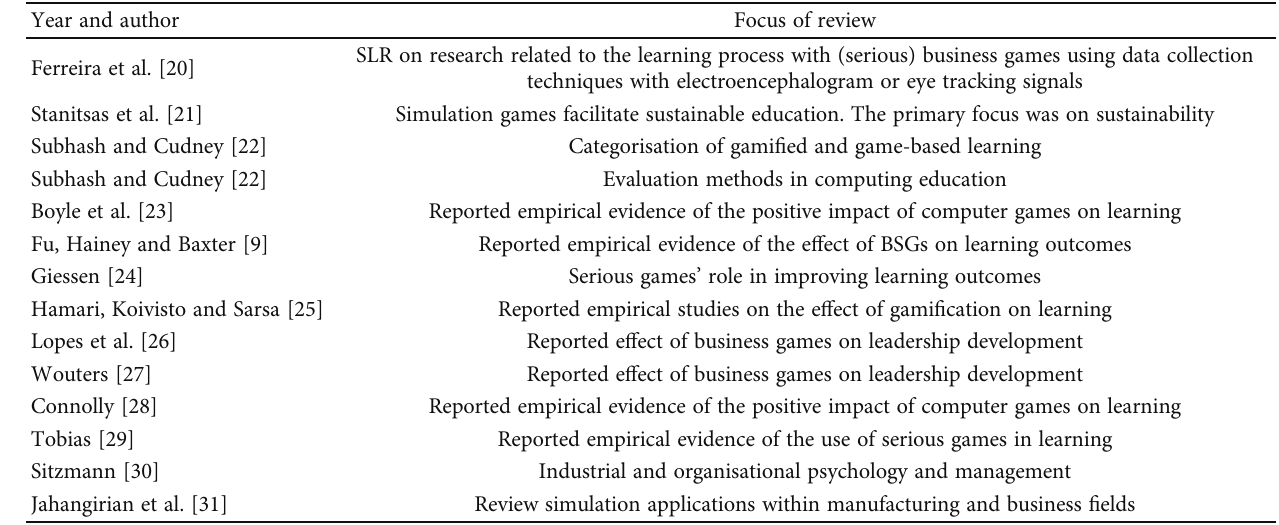
Table 1: Previous literature reviews on simulation